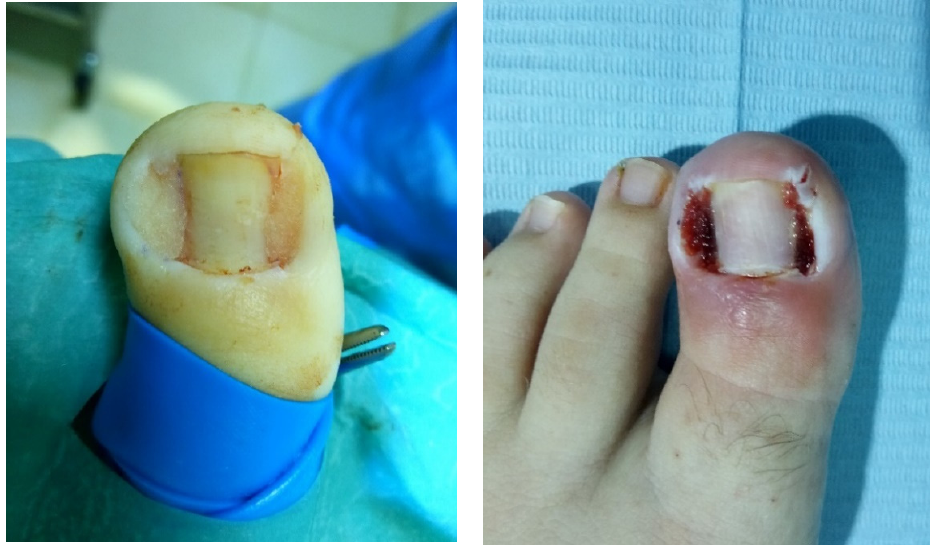
Figure 3. Immediate postoperative aspect ( left ) and 48 h after ( right ) application of gelatin sponges